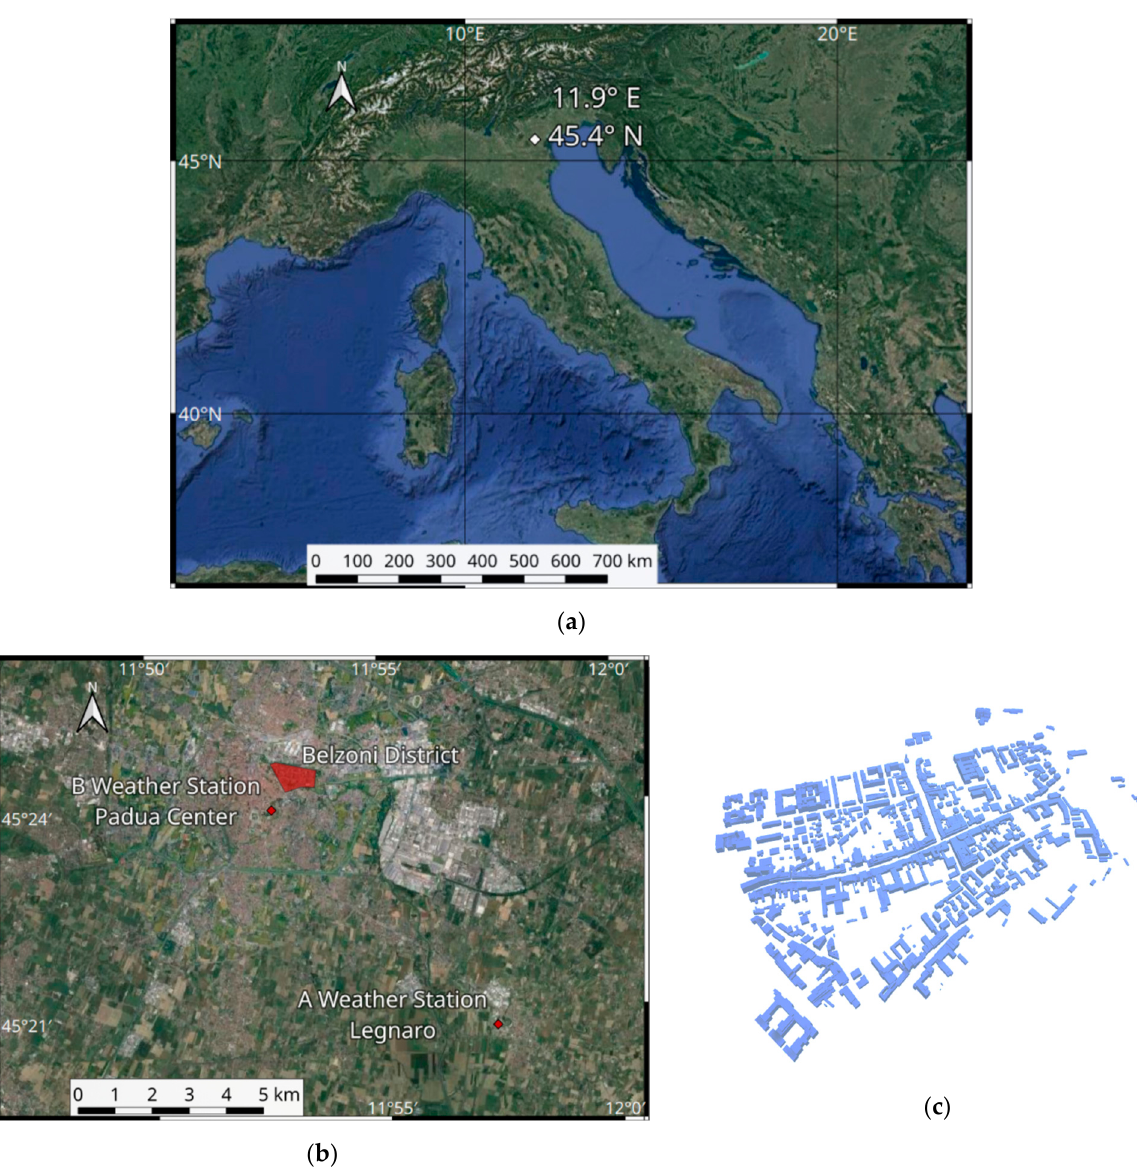
Figure 4. ( a ) Satellite image of Italy; ( b ) a particular of the Belzoni district and the weather stations in Padua; ( c ) virtual image of the Belzoni district.